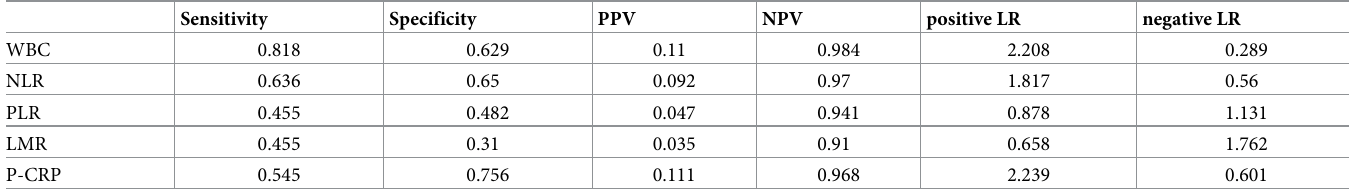
LMR and P-CRP. Finally, high WBC count had the highest sensitivity and negative predictive value, and the lowest likelihood ratio, using the cut-off value (6,200/ μ L). Preoperative WBC levels in patients with left-sided CRC can become a useful marker to rule out AL. These results reflect the influence of tumor-related inflammation in patients with CRC on the healing process of the intestinal anastomosis created in their resections. Generally, excessive inflammation is a key contributor to wound pathology, which length- ens recovery through the continued destruction of wound tissue. Along with elevated infiltra- tion by specific immune cell subsets, pathological immune cell function is perturbed and collectively contributes to poor healing [27]. Table 4. Diagnostic properties for clinical predictors of AL.